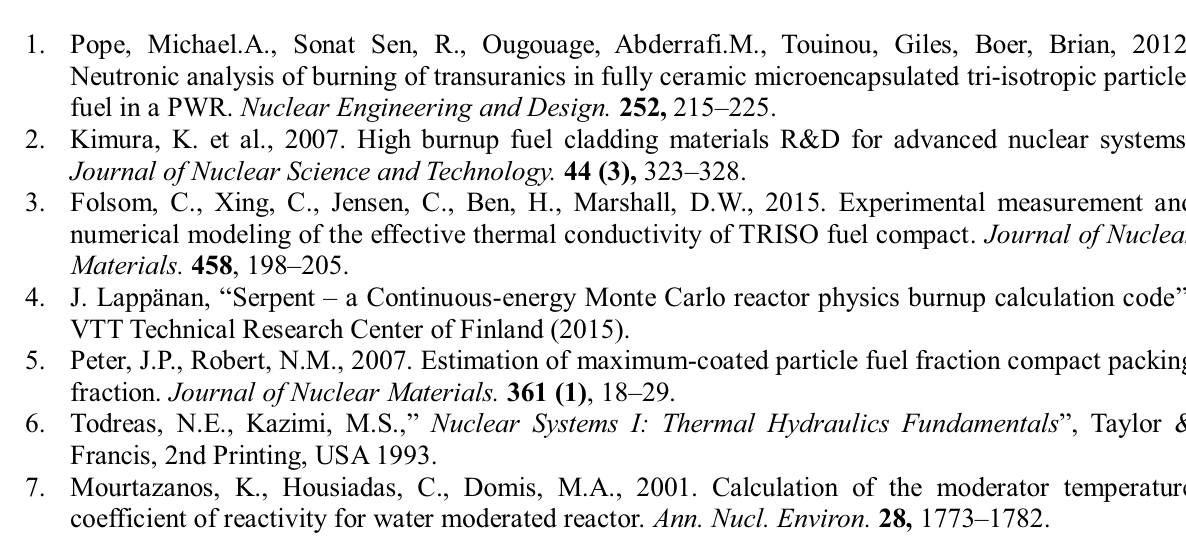
O as Burnable 2 3